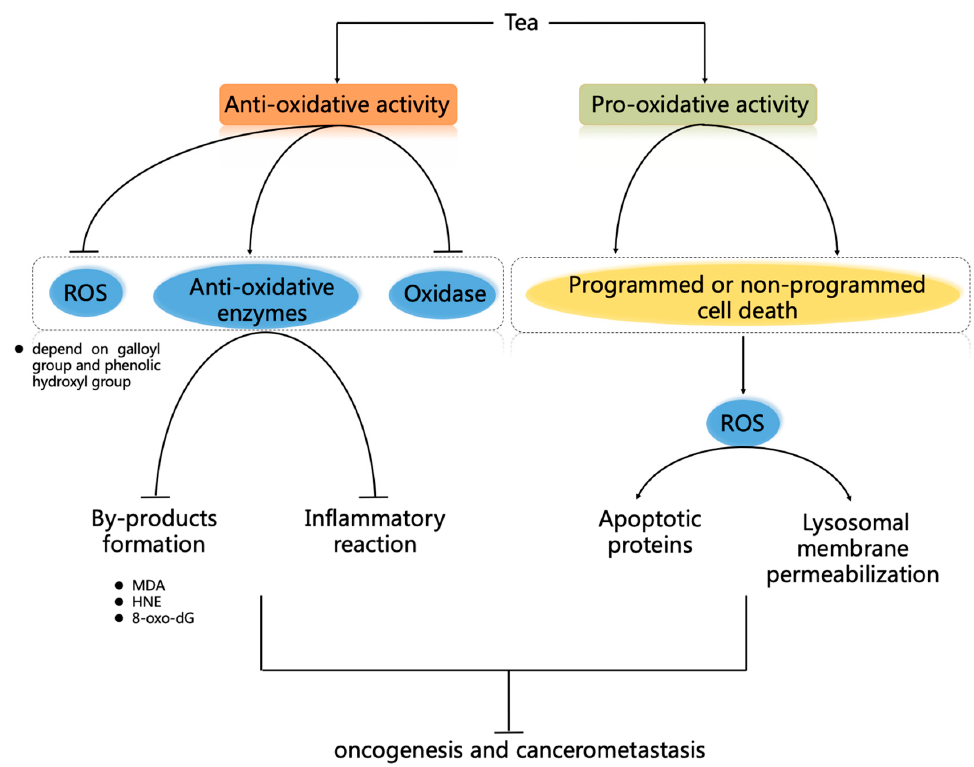
Figure 2. Anti-cancer mechanisms of tea by regulating ROS homeostasis. Anti-oxidative activity of tea. Tea polyphenols can directly scavenge ROS by depending on its B and D ring of the galloyl group,